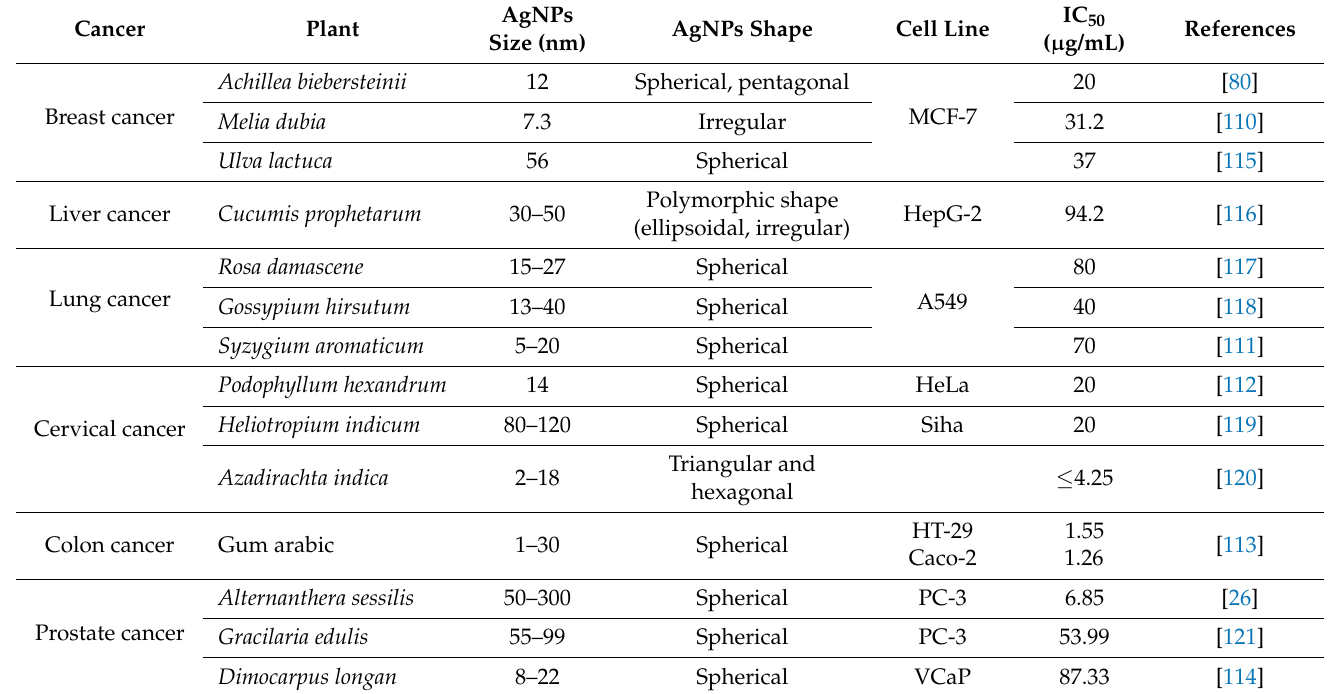
Table 5. Plant extract-synthesized AgNPs with anti-cancer